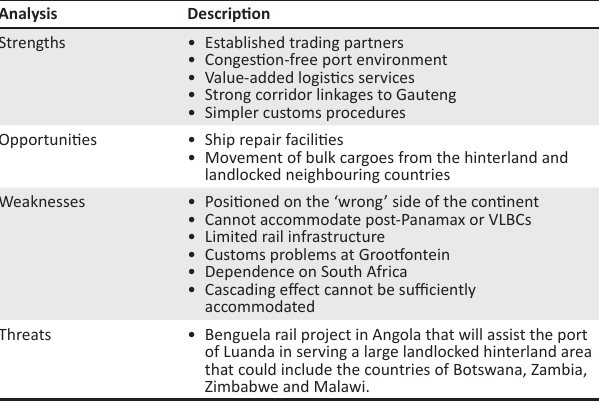
TABLE 2: Strengths, weaknesses, opportunities and threats analysis of Walvis Bay